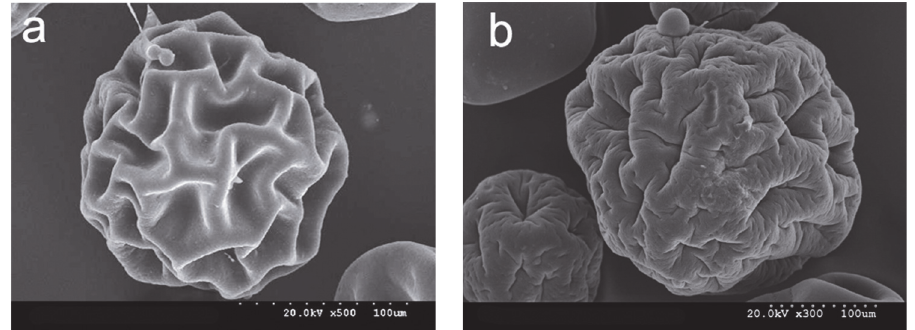
Figure 1: Scanning electron microscopy photographs of (a) alginate/gelatin BBH loaded microspheres and (b) chitosan-coated algi- nate/gelatin BBH loaded microspheres.